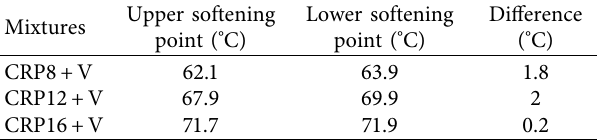
Table 10: Segregation test results in various SMA